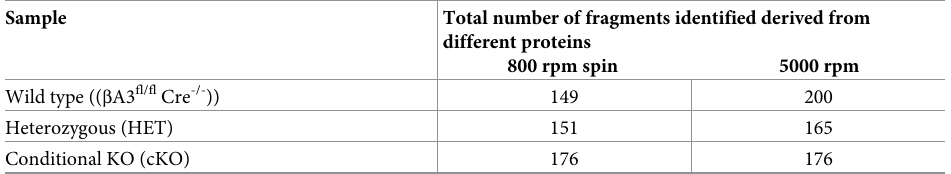
Table 1. Identification of protein fragments ( > 20 kDa) by mass spectrometric method in the pellet recovered fol- lowing 800 rpm spin and 5000 rpm spin from lenses WT ( β A3 fl/fl Cre -/- ), HET ( β A3 fl/- Cre -/+ ) and cKO [condi- tional n KO] ( β A3 fl/fl Cre -/+ )